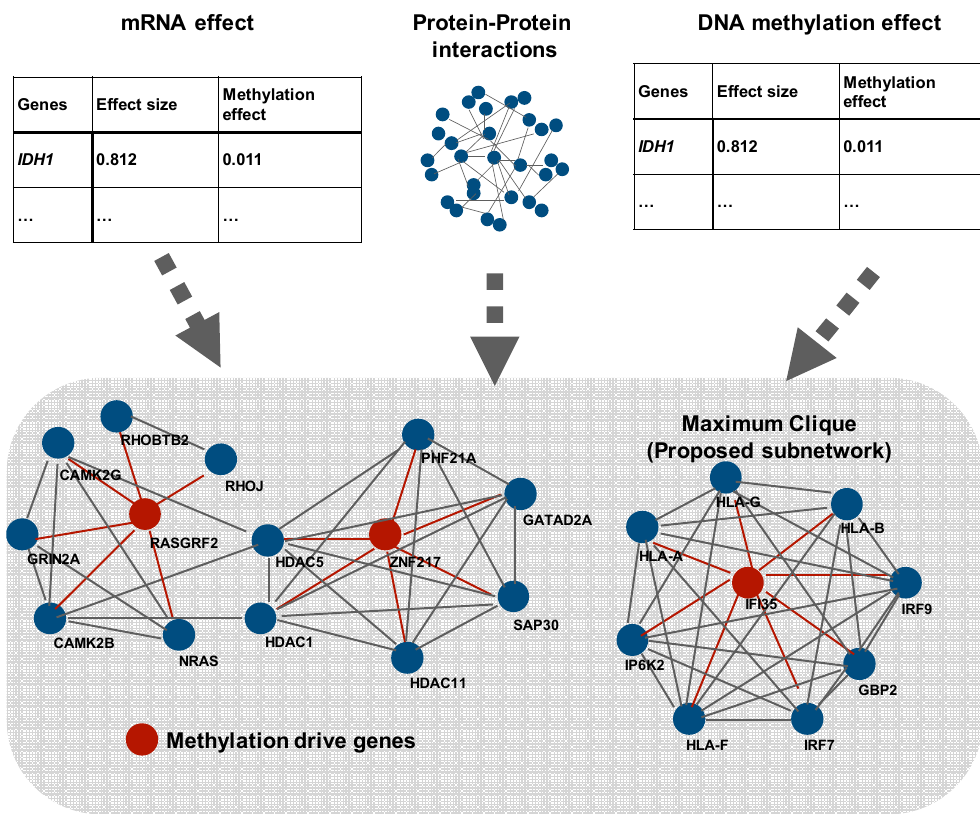
Figure 3. Creation of subnetworks consisting of methylation-driven genes, differentially expressed genes, and known interactions using a network propagation algorithm (modified from Reference [48]). As shown here, some pathway and network studies attempt to discover network genes as nodes and connections between genes as edges. Shafi et al. detected differential expressed genes and methylated genes using the leave-one-out method. Then, they combined the result of the Figure.